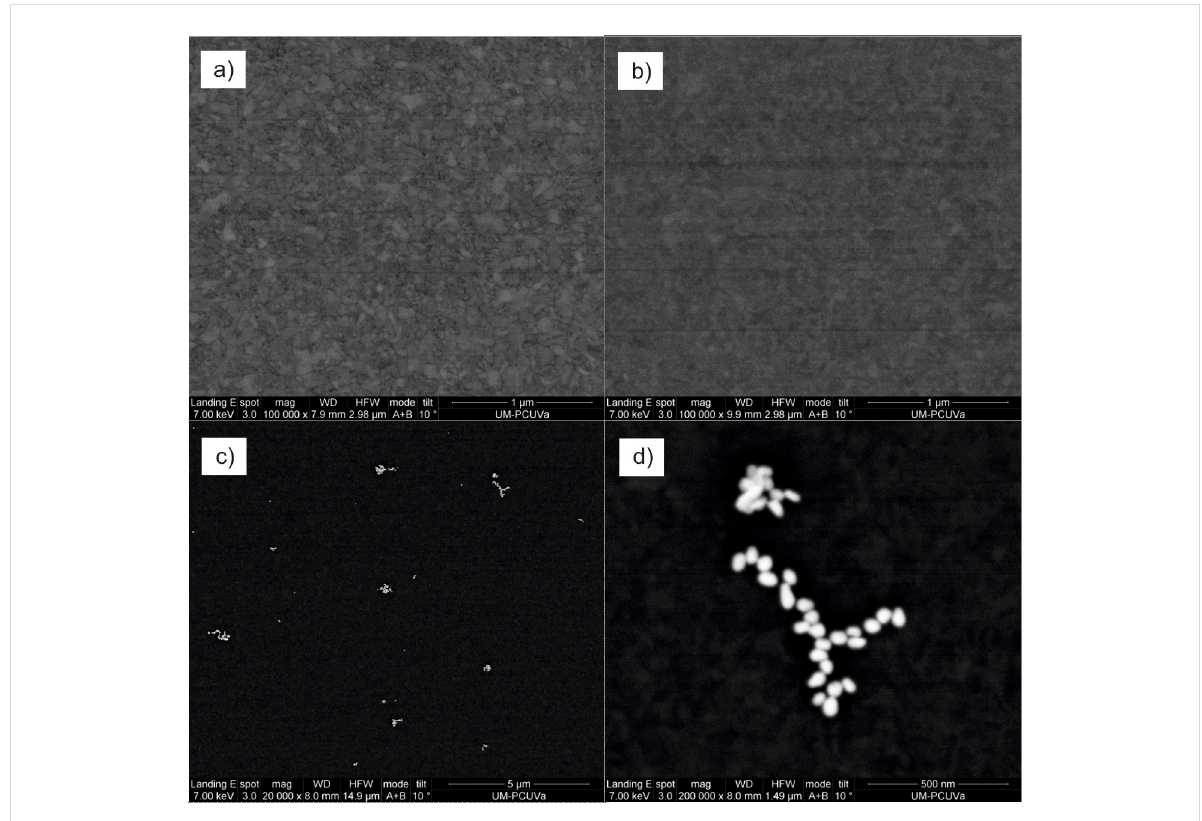
Figure 1: SEM images of electrodes modified with a) PEDOT/PSS, b) PEDOT/PSS/CuPc, c) PEDOT/PSS/AuNP and d) PEDOT/PSS/AuNP (higher magnification).